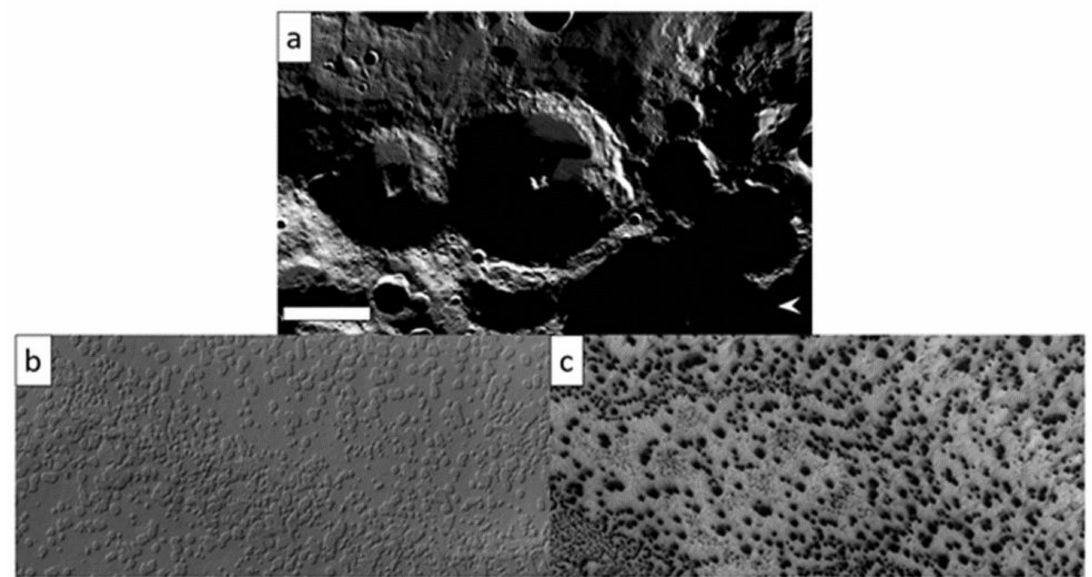
Figure 2. The lunar and Martian CO 2 -rich geologic features. ( a ) Amundsen crater on the lunar south pole as imaged by the LRO Wide-angle Camera (WAC) has been observed to have stable CO 2 volatiles within its shadowed crater walls [2]. Scale bar at 50 km; ( b ) Swiss cheese terrain from the southern Martian poles as imaged by HiRISE (ESP-012271-0940); ( c ) CO 2 “spider” geysers on the Martian surface imaged by HiRISE (ESP-012643-0945). Both HiRISE images are 5 km